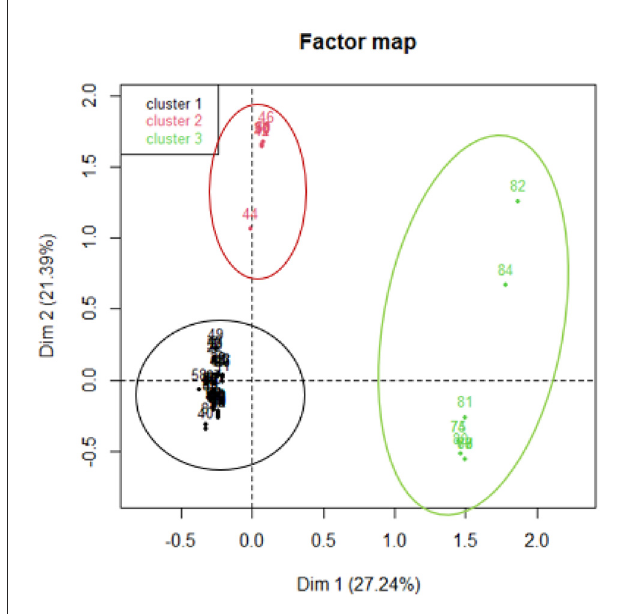
FIGURE2 Classification of cattle dairy farmers in Dassa-Zoumé and Nikki.